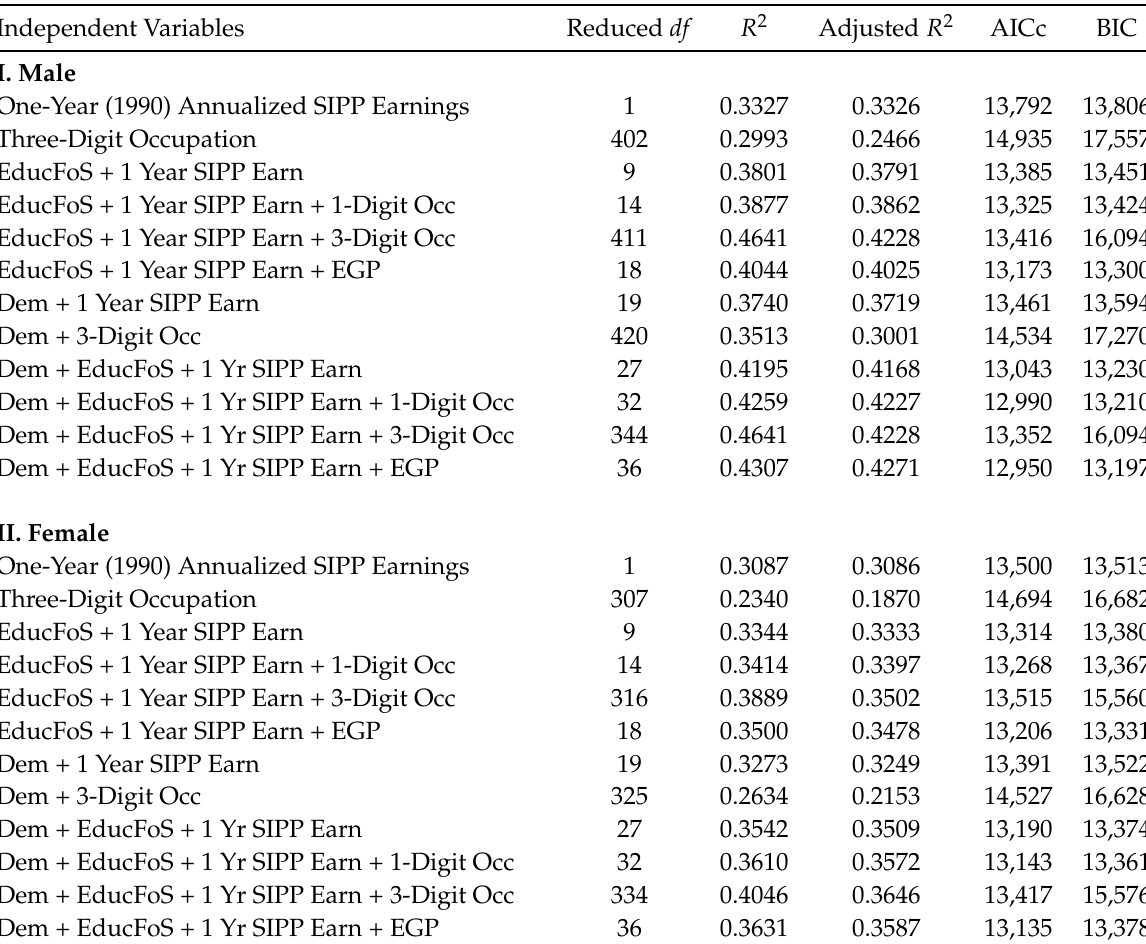
Table 4: Results for OLS models of log–long-term earnings using samples limited to those who reported SIPP self-reported